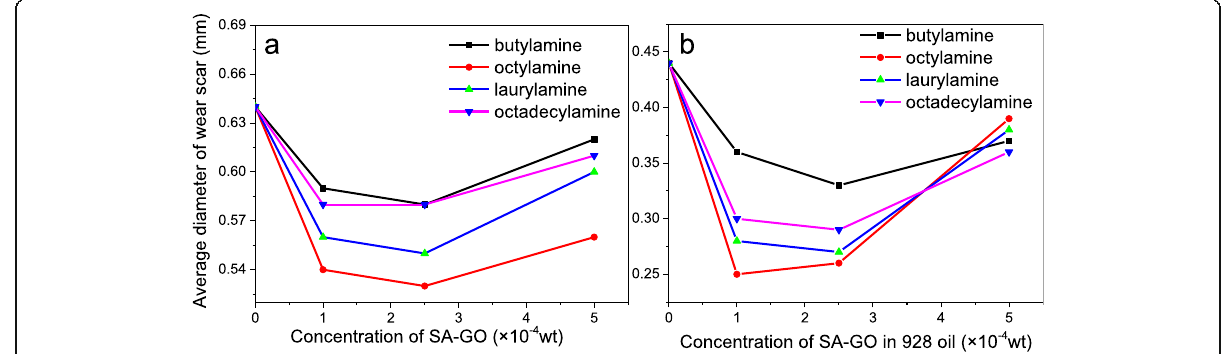
Fig. 8 The average diameter of wear scar while the SA-GO (prepared by sulfur-doped GO and butylamine, octylamine, laurylamine, and octadecylamine; the oxidation time of the GO is 24 h) is applied as lubrication additive in PAO4 ( a ) and 928 ( b ) oils